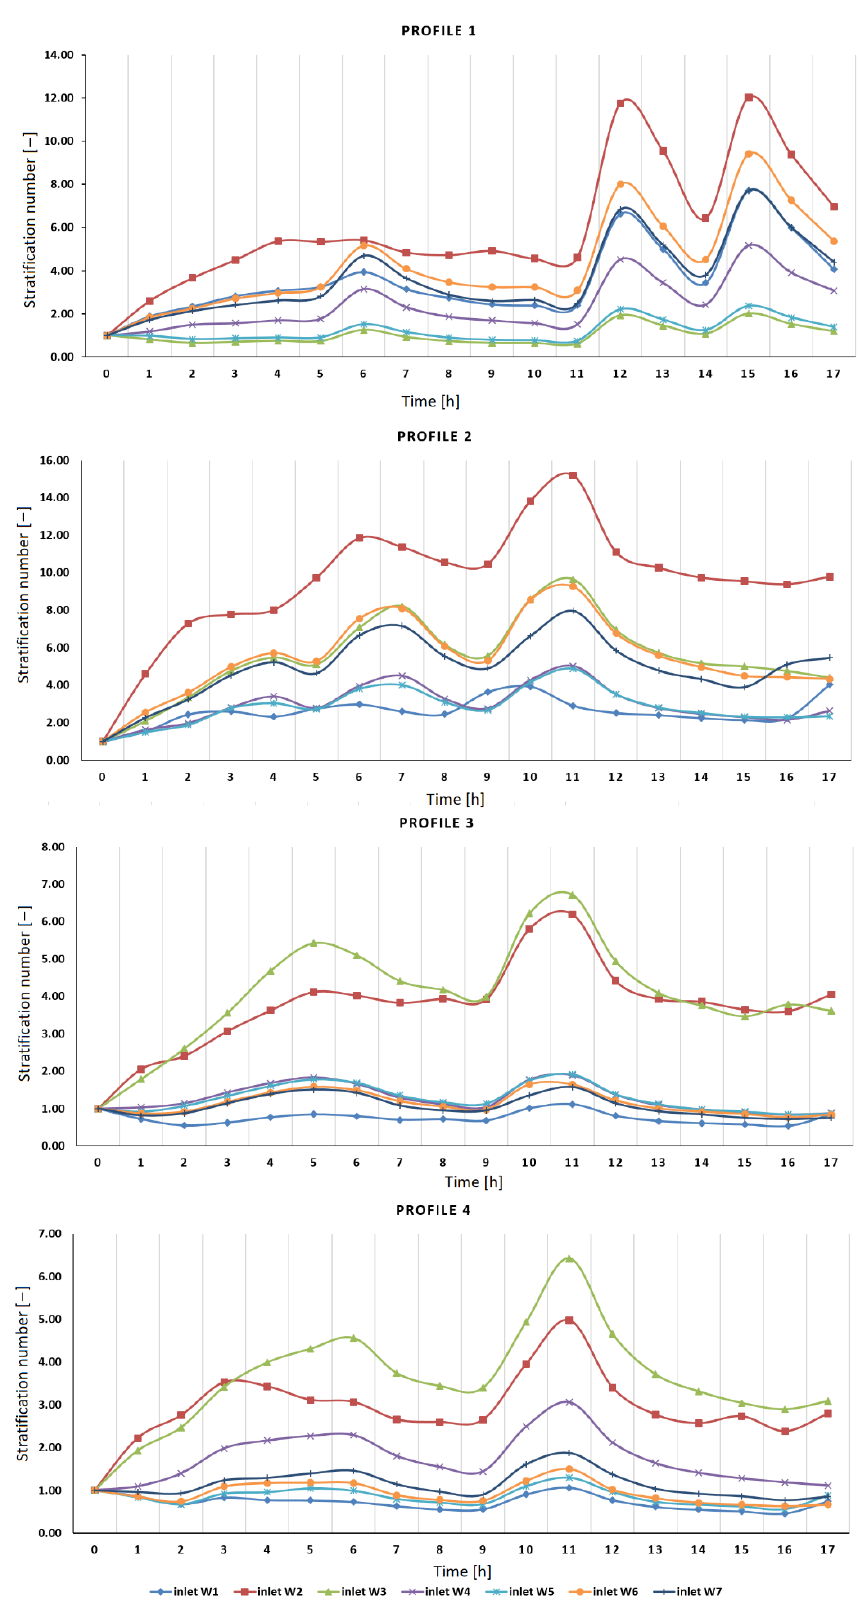
Figure 8. Stratification number inside the tank during hot water consumption.